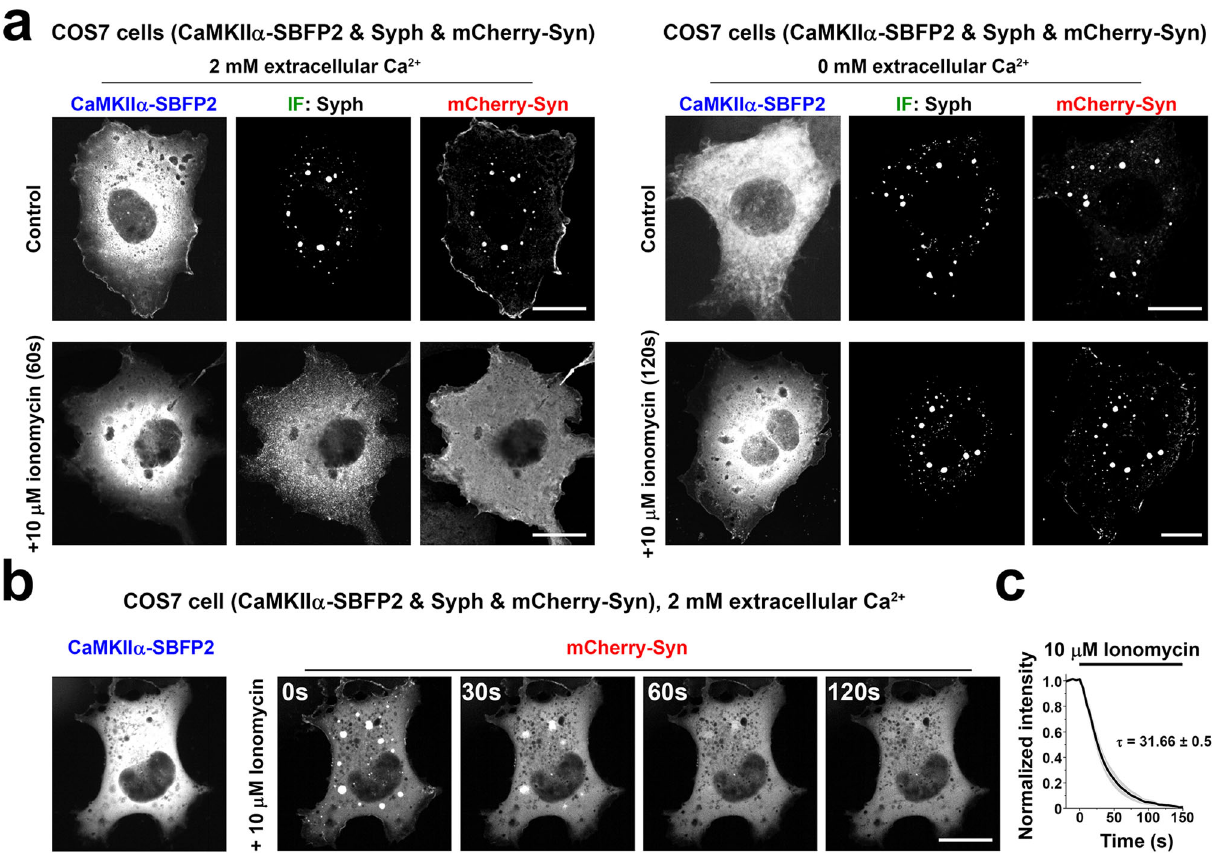
Fig. 7 Activation of CaMKII dissociates synaptophysin and synapsin droplets. a – c COS7 cells were co-transfected with CaMKII α -SBFP2, synaptophysin, and mCherry-synapsin. a Transfected cells were incubated with either vehicle or 10 μ M ionomycin for 60 s in tyrode buffer containing either 2 mM Ca 2 + (left) or 0 mM Ca 2 + (right) and then immediately fi xed. Synaptophysin was visualized by immuno fl uorescence (IF). b Representative time-lapse images